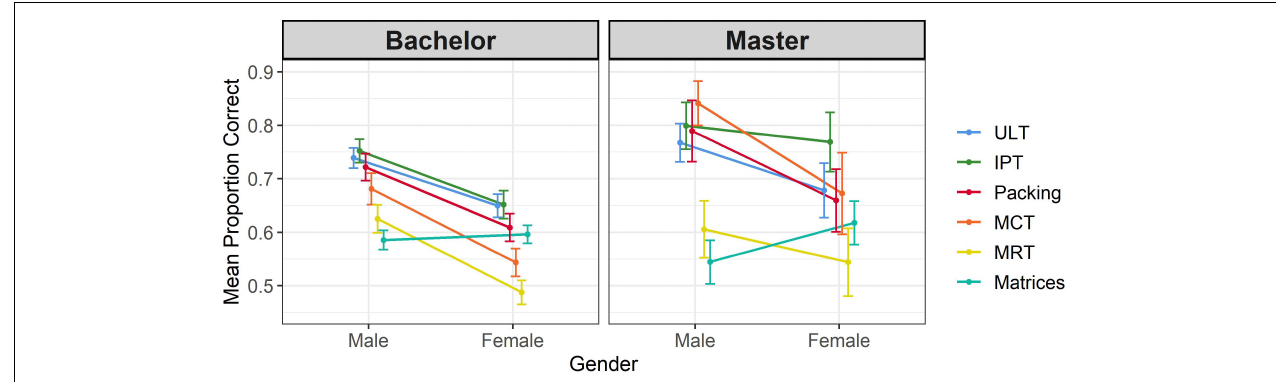
FIGURE 5 | Test performance by gender and degree. Error bars indicate 95% confidence